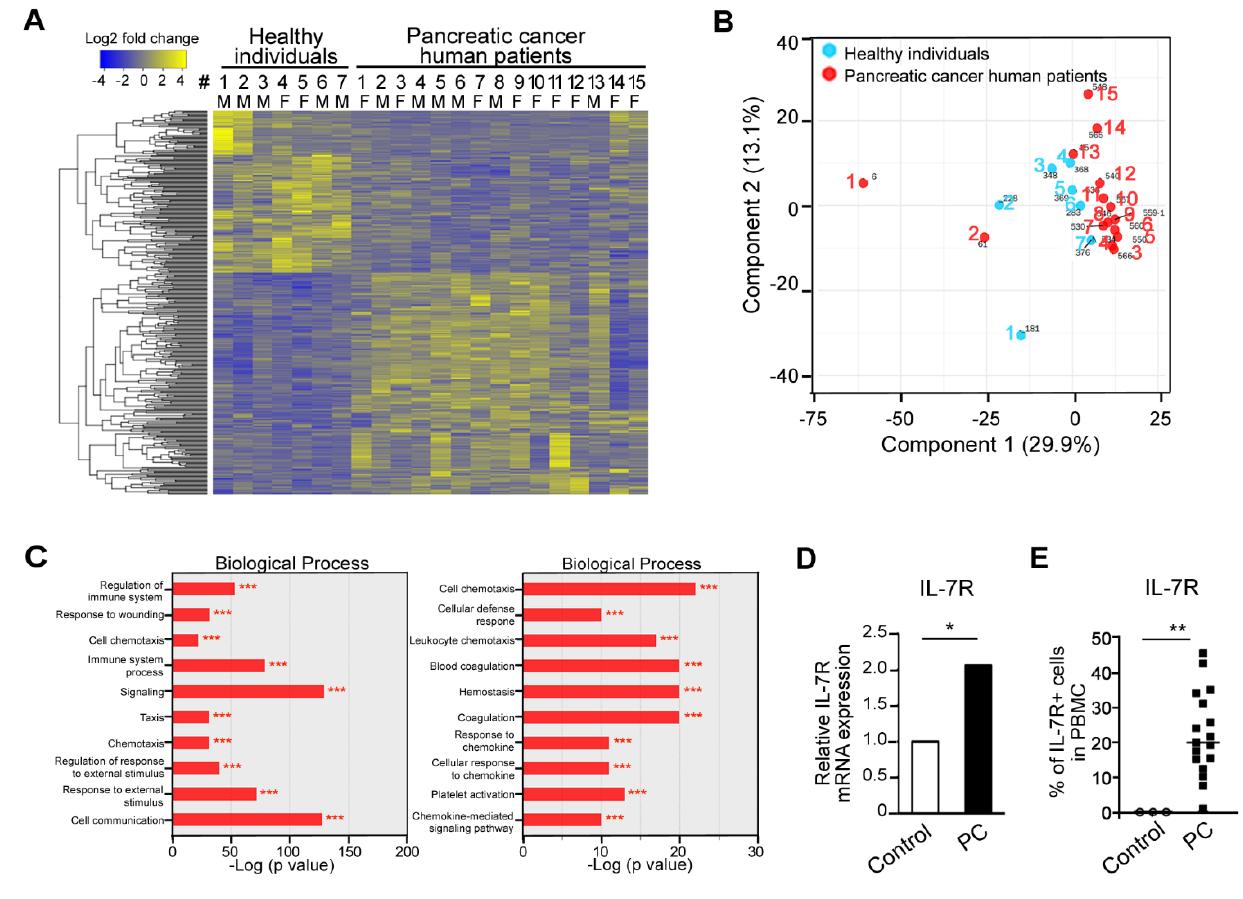
245 Figure 1. Transcriptomic analysis of PBMCs from normal individuals and pancreatic cancer patients for biomarker